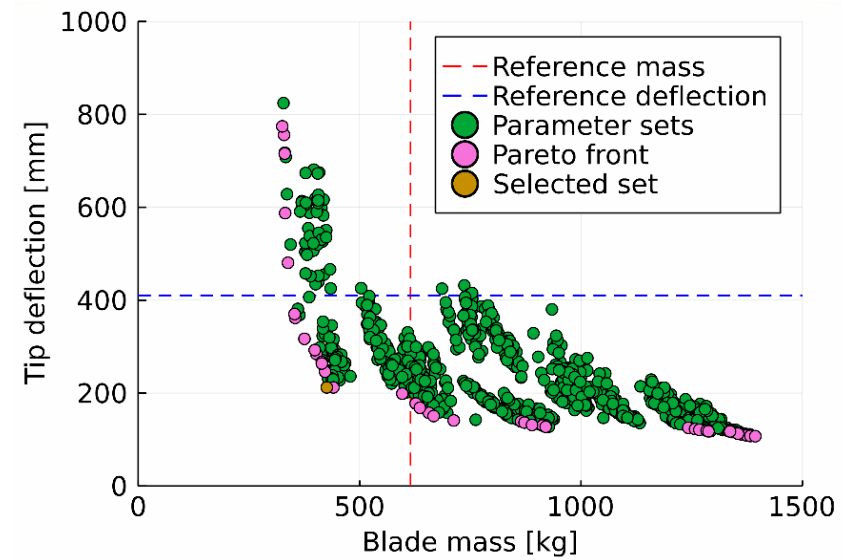
Figure 11. Results of the generated blades.